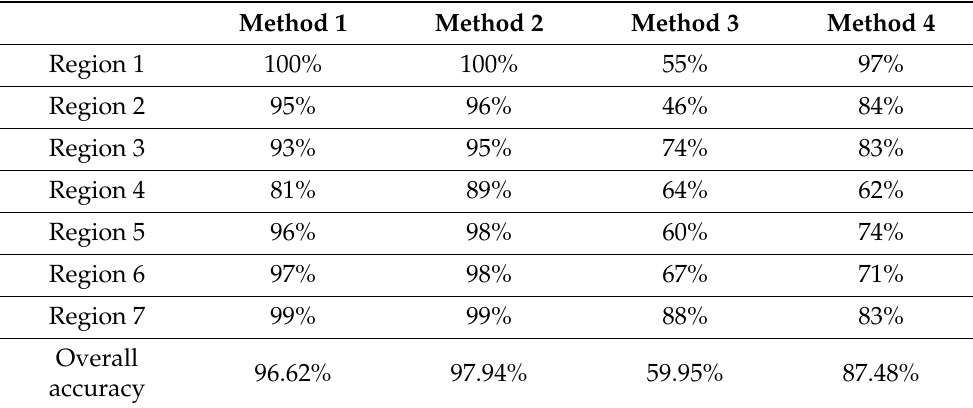
Table 9. Comparative results of the estimation accuracy of each gaze region for the four Oculus-based methods and all the